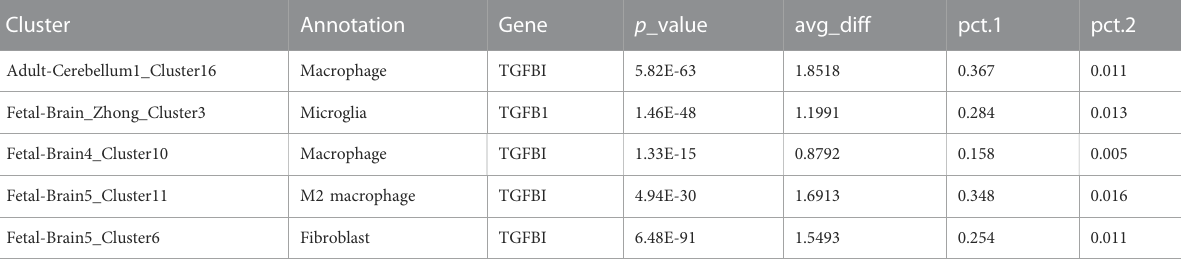
TABLE 3 TGFB1 and TGFBI are the top markers for microglia/macrophage in the brain.